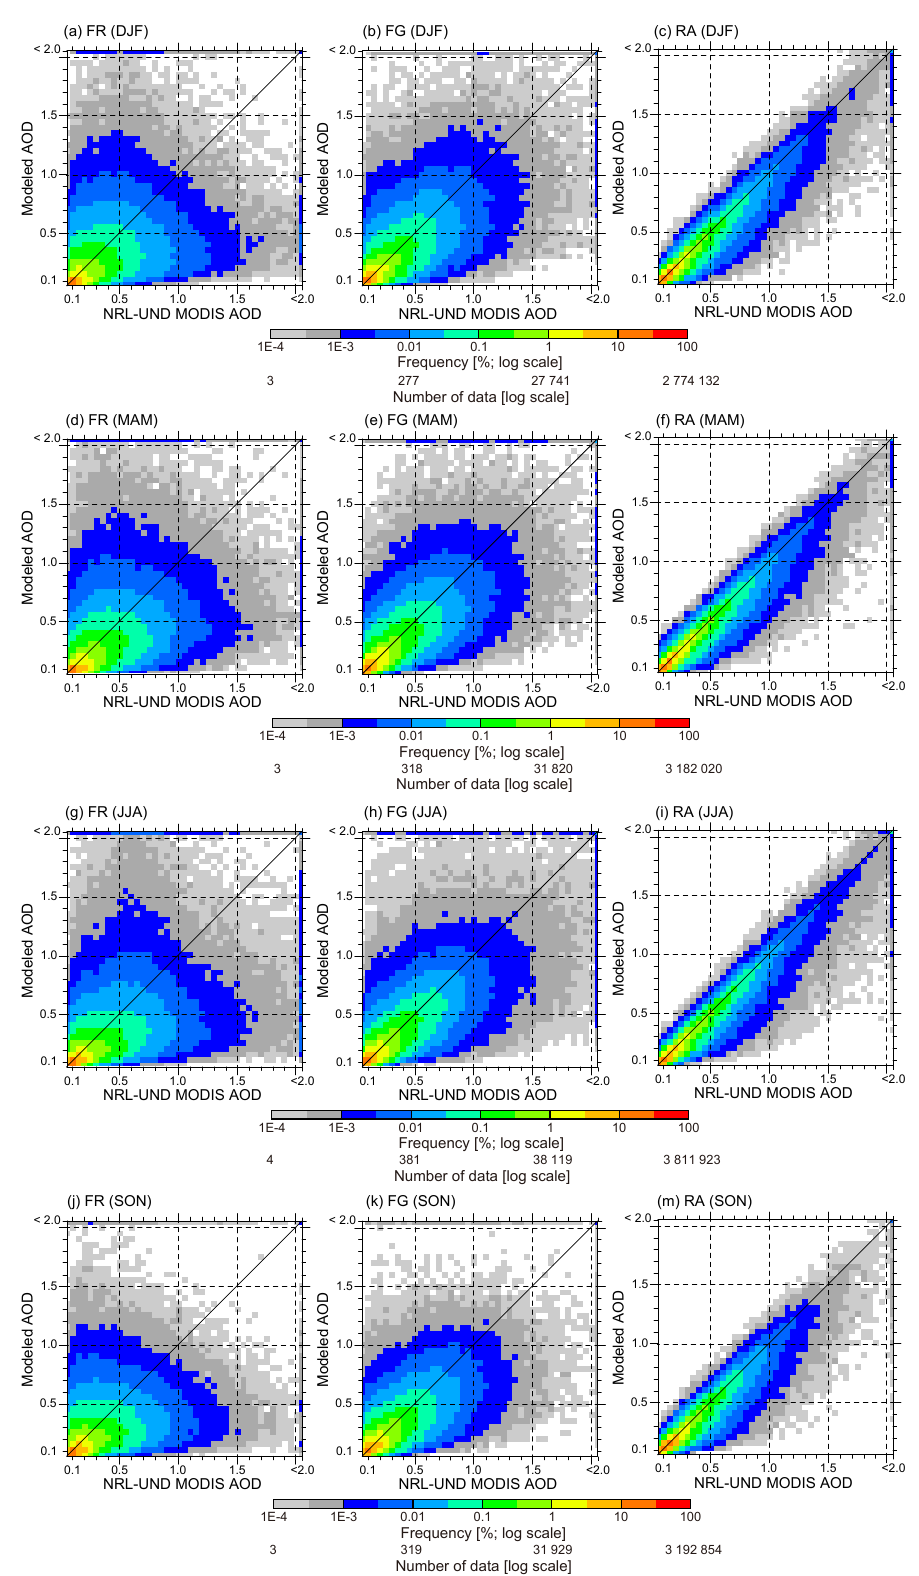
Figure 9. Scatter plots of FR (a, d, g, j) , FG (b, e, h, k) , and RA (c, f, i, m) AODs versus NRL-UND MODIS AODs for boreal (a–c) winter (December–February), (d–f) spring (March–May), (g–i) summer (June–August), and (j–m) autumn (September–November). Geosci. Model Dev., 10, 3225–3253,